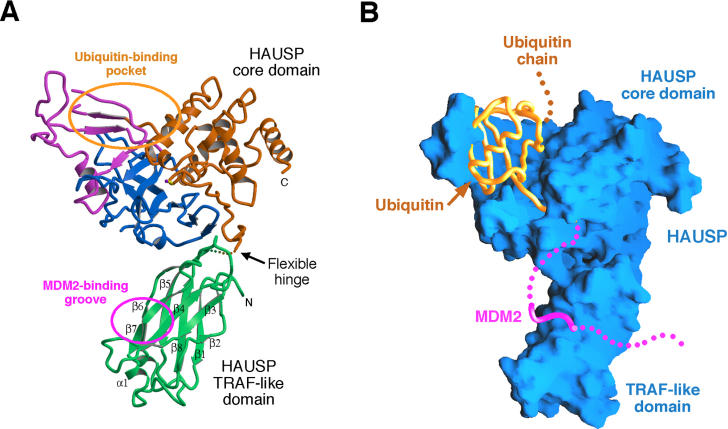
Structure of an Extended HAUSP Fragment(A) Structure of a HAUSP fragment (residues 53–560) that contains both the substrate-binding (green) and the catalytic domains. Binding sites for ubiquitin and substrate are indicated. The linker sequences between these two domains have high-temperature factors and are flexible in the crystals.(B) A structure-based model showing HAUSP bound to an ubiquitylated MDM2. Only one ubiquitin moiety and the MDM2 peptide are shown in this model.